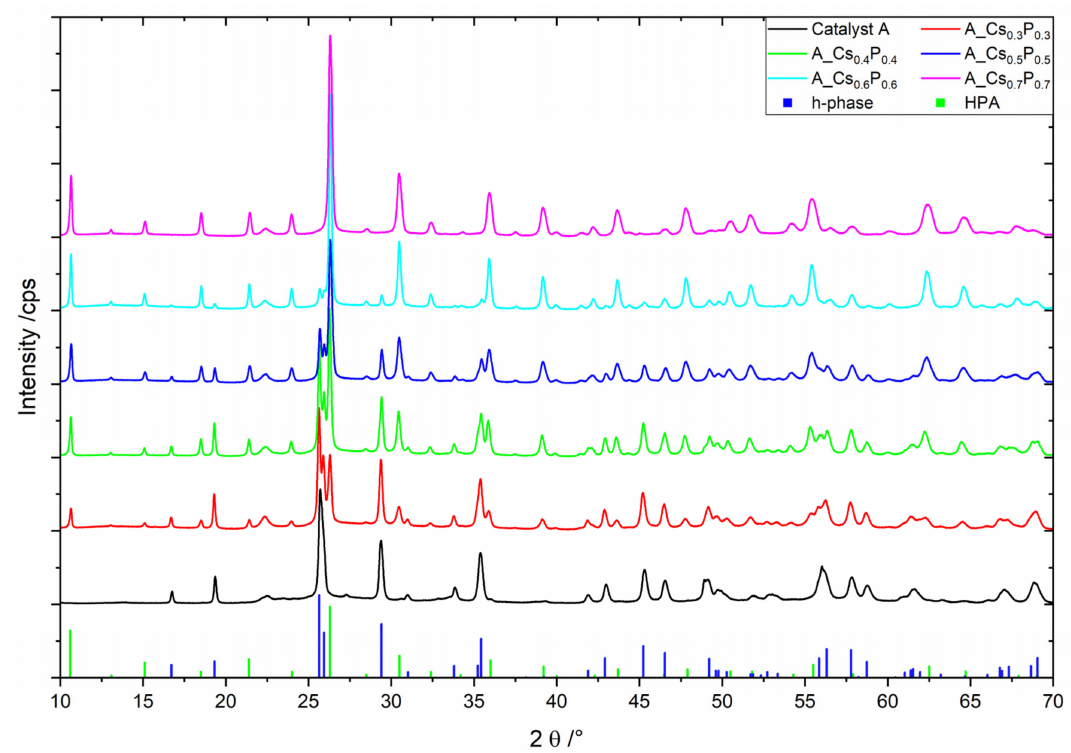
Figure 5. XRD pattern of catalyst A prior to and after adding Cs and P with different (Mo + V + W)/P ratios at a constant Cs/P ratio of 1. Characteristic XRD reflexes of h-phase (blue bars) and HPA (green bars). Table 2. Chemical composition, estimated crystallinity, estimated phase composition and BET surface area of catalyst A prior to and after adding Cs and P with different (Mo + V + W)/P ratios at a constant Cs/P ratio of 1. Catalyst Chemical Composition A 0